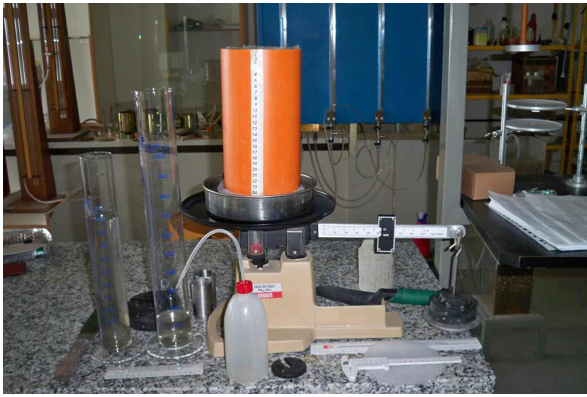
Figure 3: PVC cylindrical cell for the preliminary evaluation of the water retention potential of the coal.